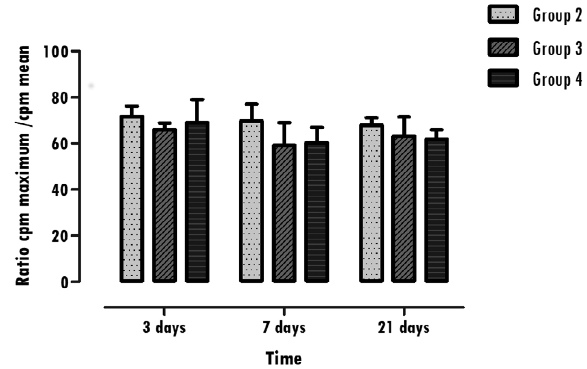
Figure 5- Representative graphic of the results obtained with the molecular image after 99mTc-HMDP administration. The values represent the mean and standard deviation of the ratio obtained between the operated hemimandible maximum counts and contralateral hemimandible mean counts at three, seven and twenty-one days in each group with different biomaterials, Groups 2, 3, and